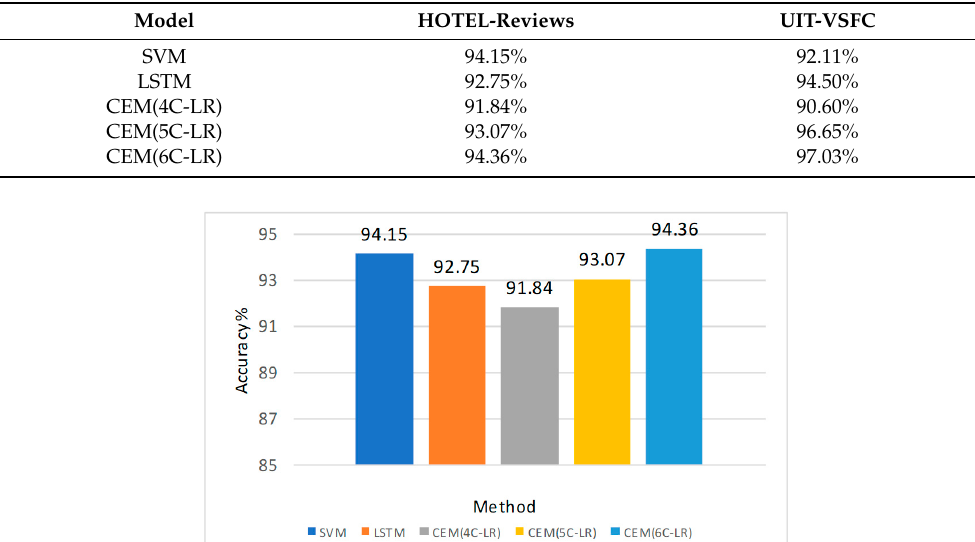
Table 6. Results experimented on two corpuses of reviews about hotels in Vietnam (HOTEL- and UIT-VSFC. Reviews) and UIT-VSFC.